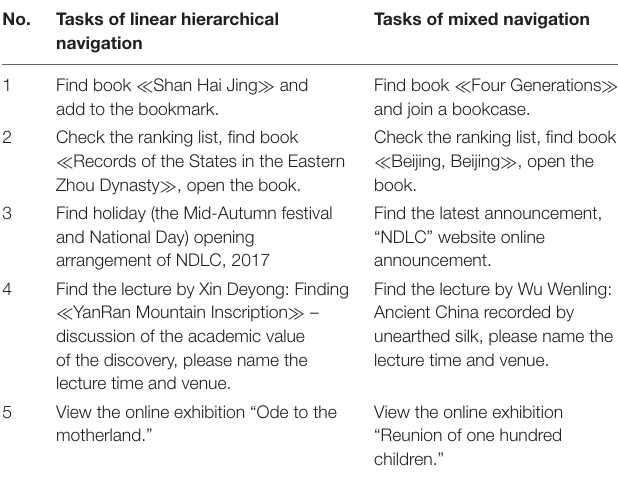
TABLE 1 | Experimental